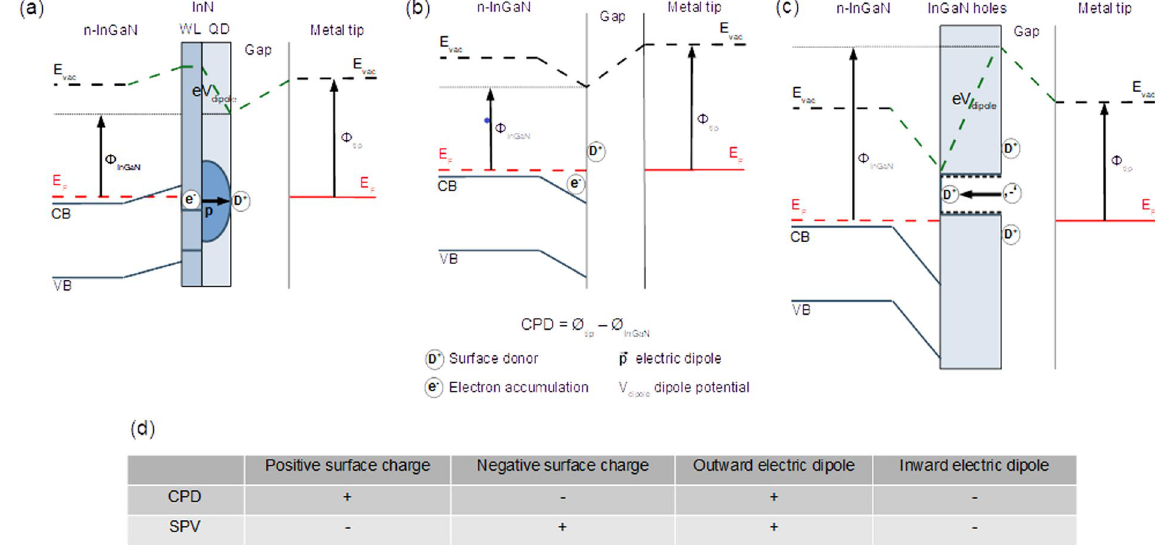
Figure 3. Band diagrams and CPD/SPV trends. Energy band diagrams in the dark together with sketches of the respective structures and charge distributions for the c-plane of an In-rich InGaN layer with ( a ) outward surface electric dipole, ( b ) positive surface charge alone and ( c ) inward surface electric dipole. The layers are in equilibrium with the metal tip. φ tip and φ InGaN are the tip- and sample work functions. V dipole is the dipole potential. ( d ) Trends of the CPD and SPV for positive surface charge, negative surface charge, outward electric dipole and inward electric dipole. + indicates trend towards increasing, positive values and − indicates trend towards decreasing, negative CPD/SPV values for increase of the respective charge/dipole